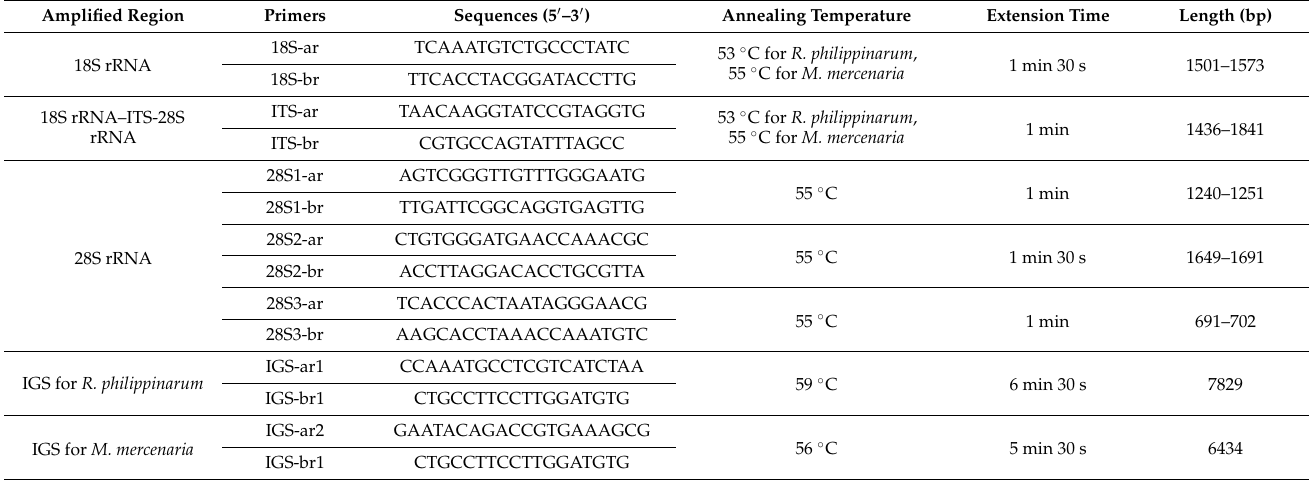
Table 2. PCR amplification